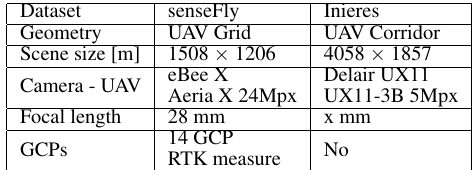
Table 1. Dataset description - The highway and the UX11 Dataset